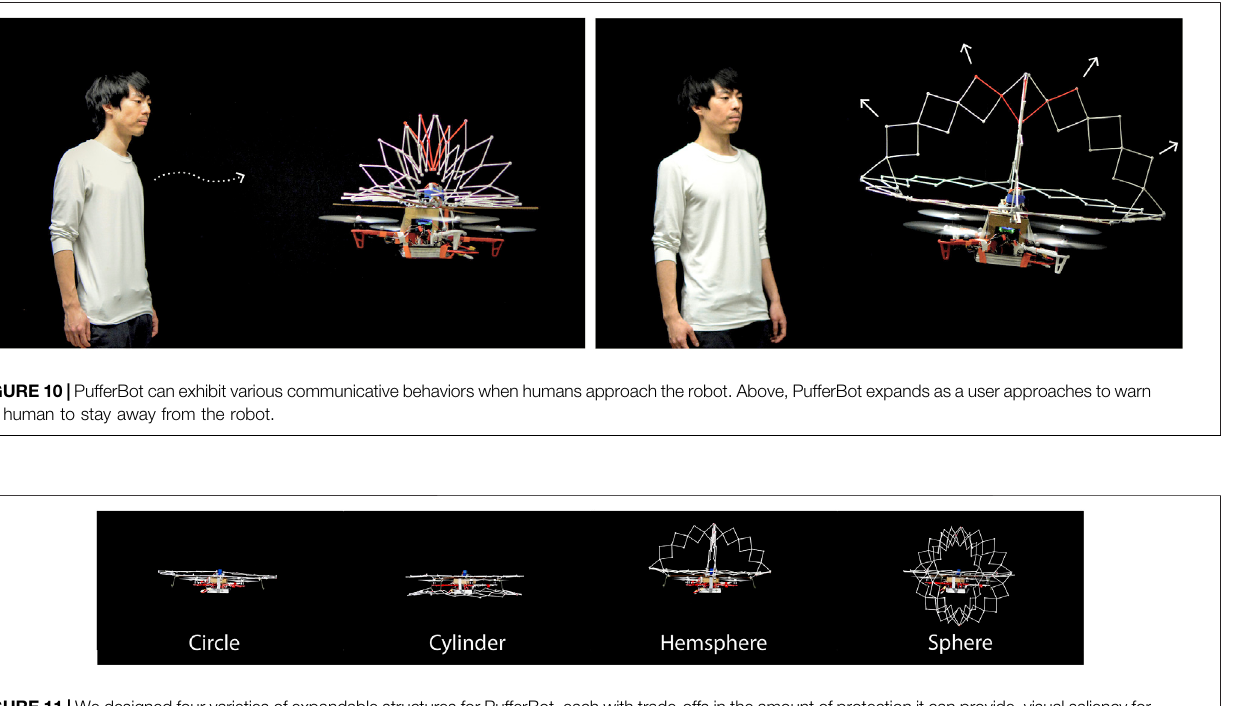
FIGURE 11 | We designed four varieties of expandable structures for PufferBot, each with trade-offs in the amount of protection it can provide, visual saliency for communication purposes, and weight.